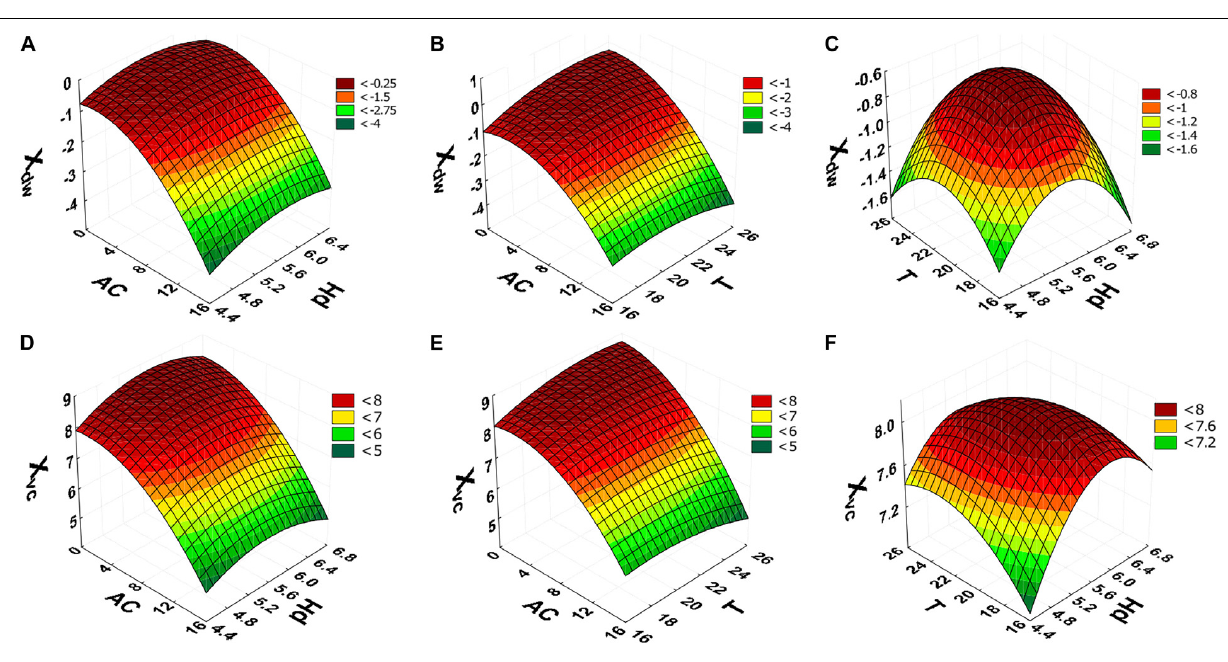
FIGURE 2 | Central composite rotatable design (CCRD 2 3 ) response surfaces. X dw dependent variable (A–C) ; results to X vc (D–F) . AC, alcohol content ( ◦ GL). pH, potential of hydrogen; T, temperature ( ◦ C); Xdw, S. boulardii biomass formation (Log 10 g in dry weight L − 1 ); X vc , viable S. boulardii concentration (Log 10 viable cells mL − 1